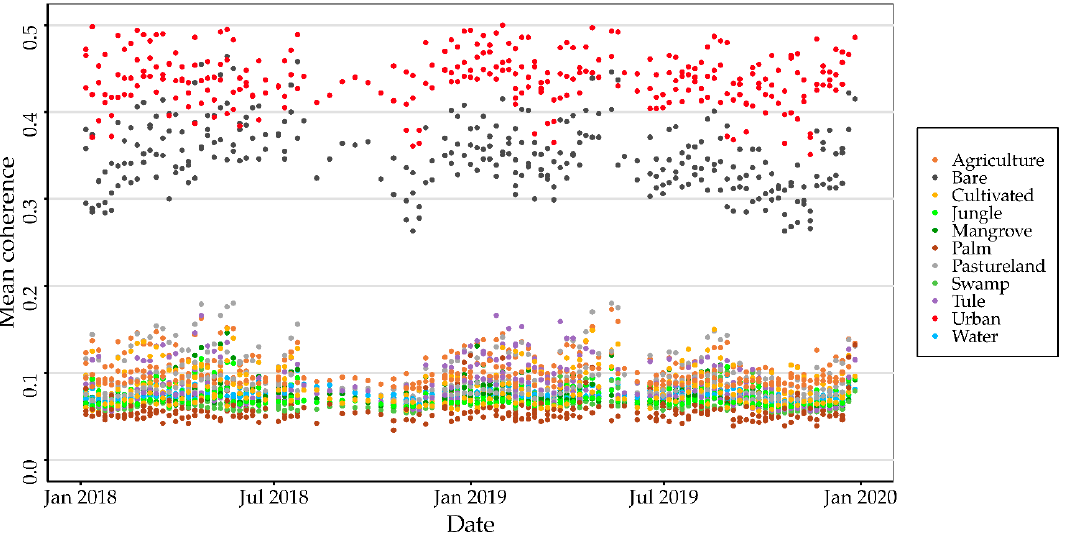
Figure 8. Average coherence for different land cover classes, estimated for image pairs obtained from the descending orbital pass during the 2018–2019 period.